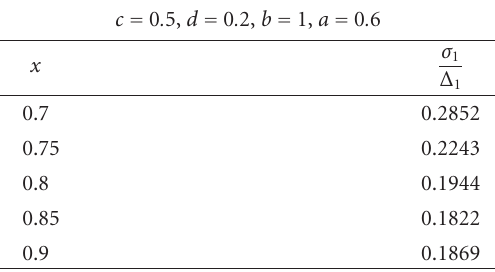
Table 3.1. Numerical results for problem